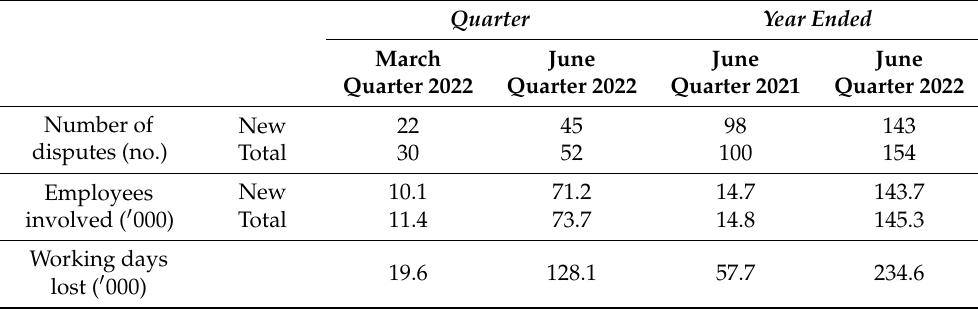
Table 1. Current situation of disputes in Australia (source: Australian Bureau of Statistics, Industrial Disputes, Australia, June